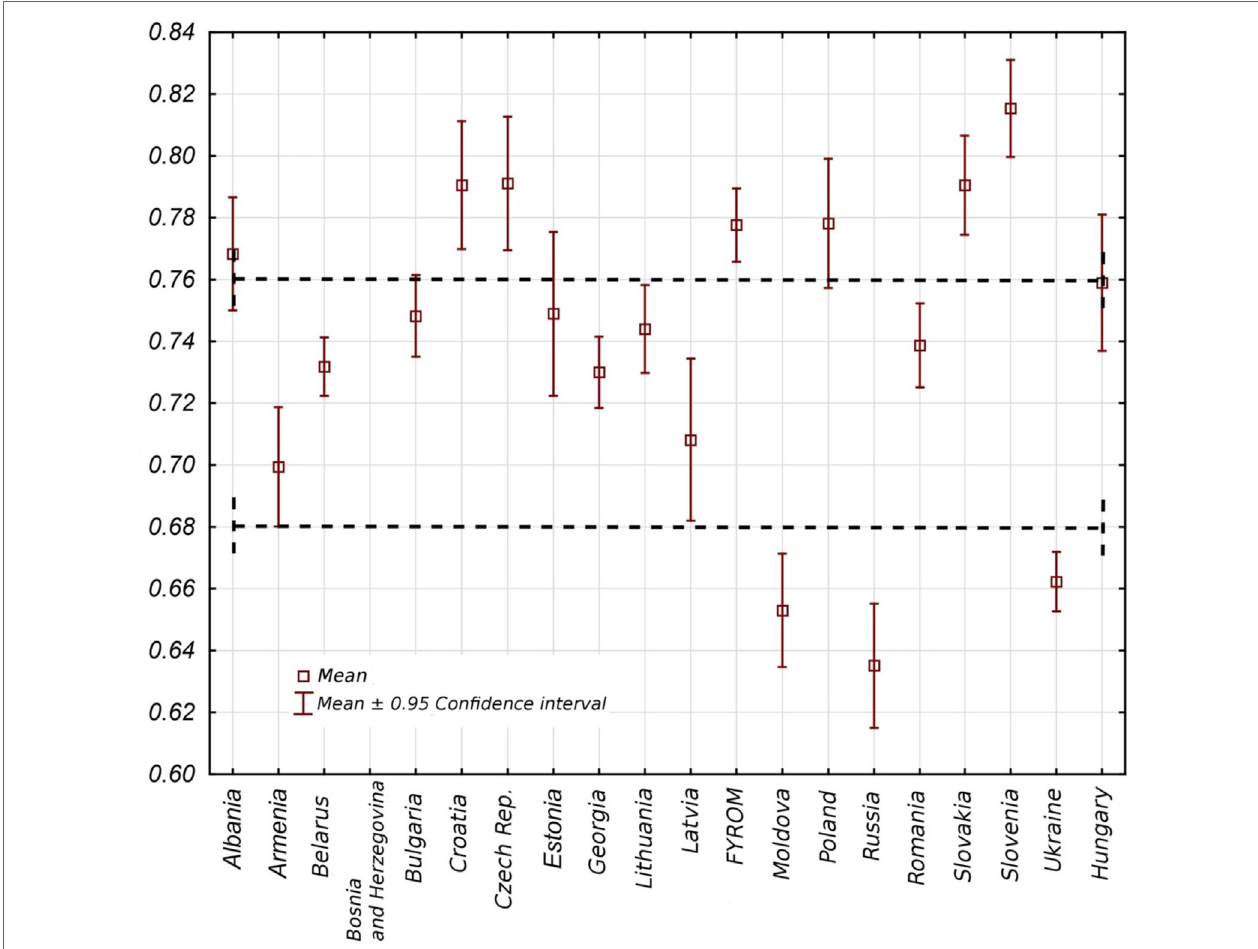
FIGURe 1 | Synthetic outcome measure values for post-communist countries in period